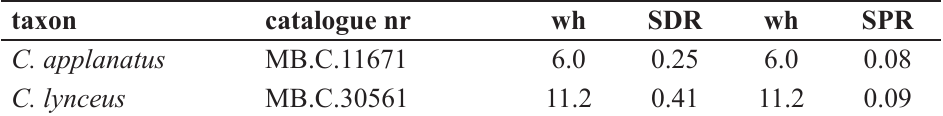
Table 15. Siphuncular diameter ratio (SDR) and siphuncular distance ratio (SPR) at their corresponding whorl height in specimens of Cyclolituites Remelé, 1886.